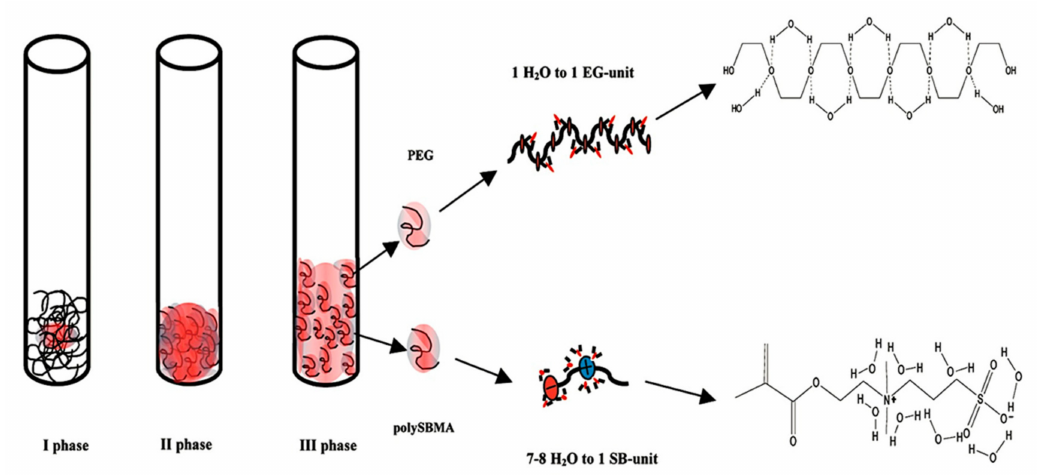
Figure 4. A proposed model of the hydration process of both PEG and polySBMA polymers. The red dots with two black sticks represent one water molecule, while the black lines represent linear polymer chains. The hydration of polymers might go through three stages with increasing water content: water molecules tightly bind to polymers, saturate binding sites of polymers, and finally swell and dissolve polymers. One water molecule could bind with one ethylene glycol (EG) unit through two H bonds, while about eight water molecules could fully hydrate an sulfobetaine (SB) group through electrostatic force. Reproduced with permission from Reference